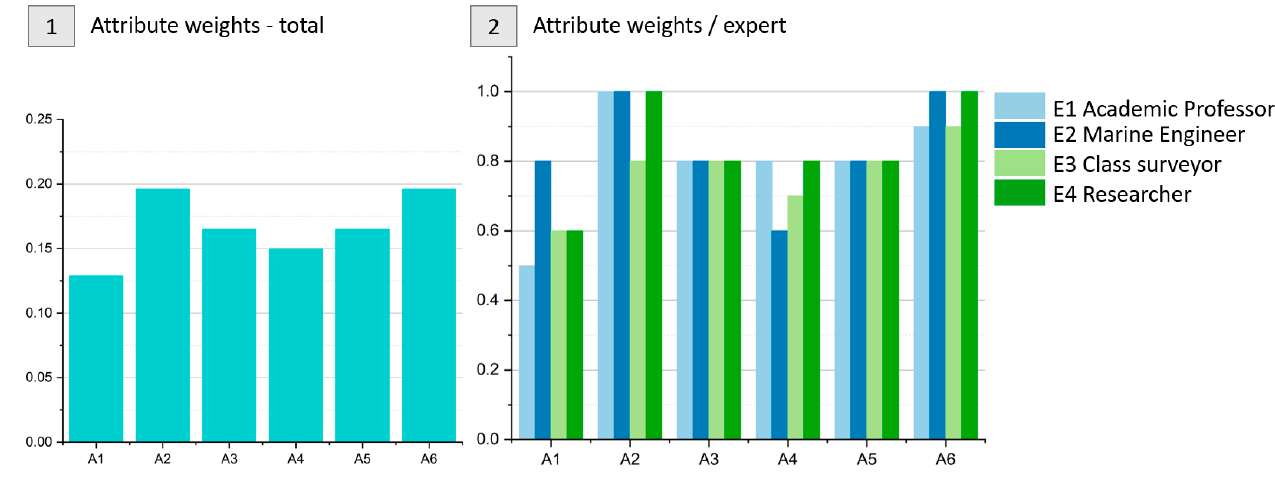
Figure 9. Attribute weights by experts .